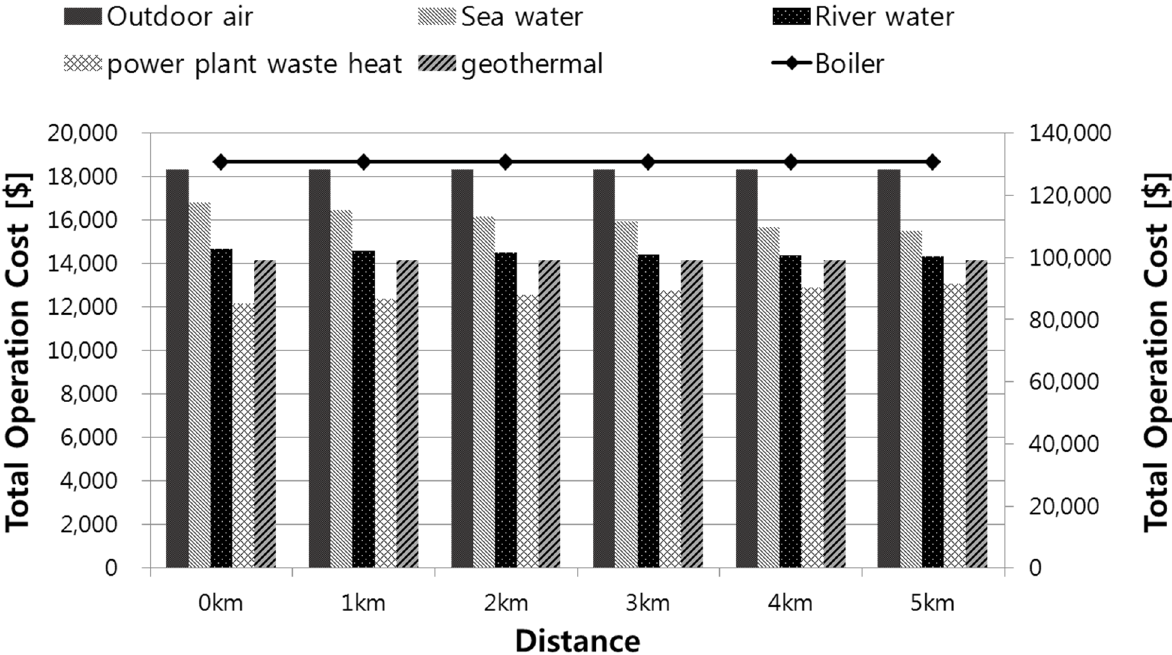
Figure 8. Gas & electric consumption and operation cost according to distance (Unit: